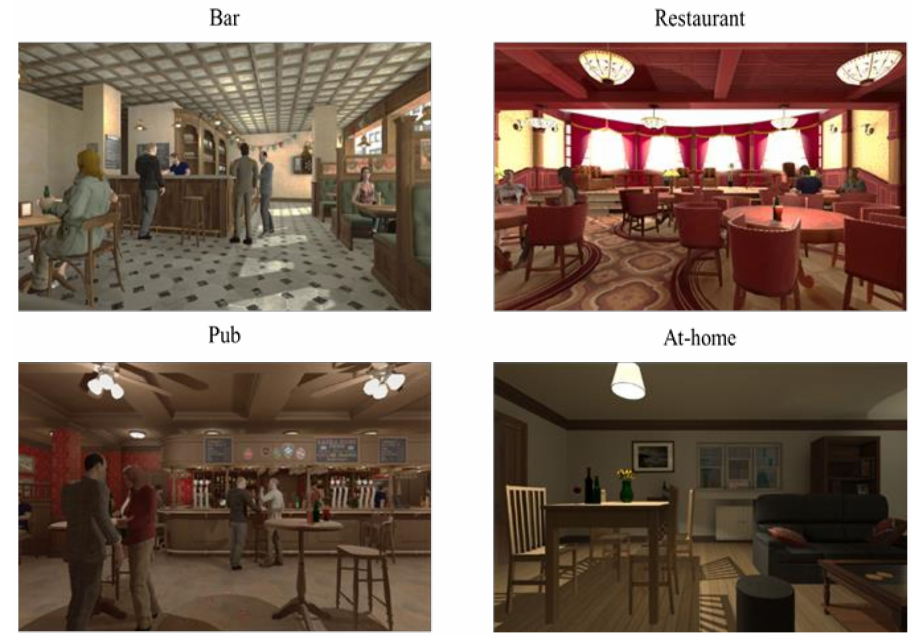
Figure 1. Images of the “ALCO-VR”